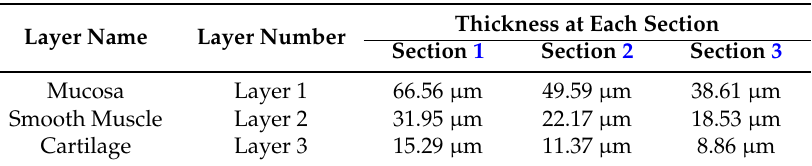
Table 1. Material model for each layer of the airway